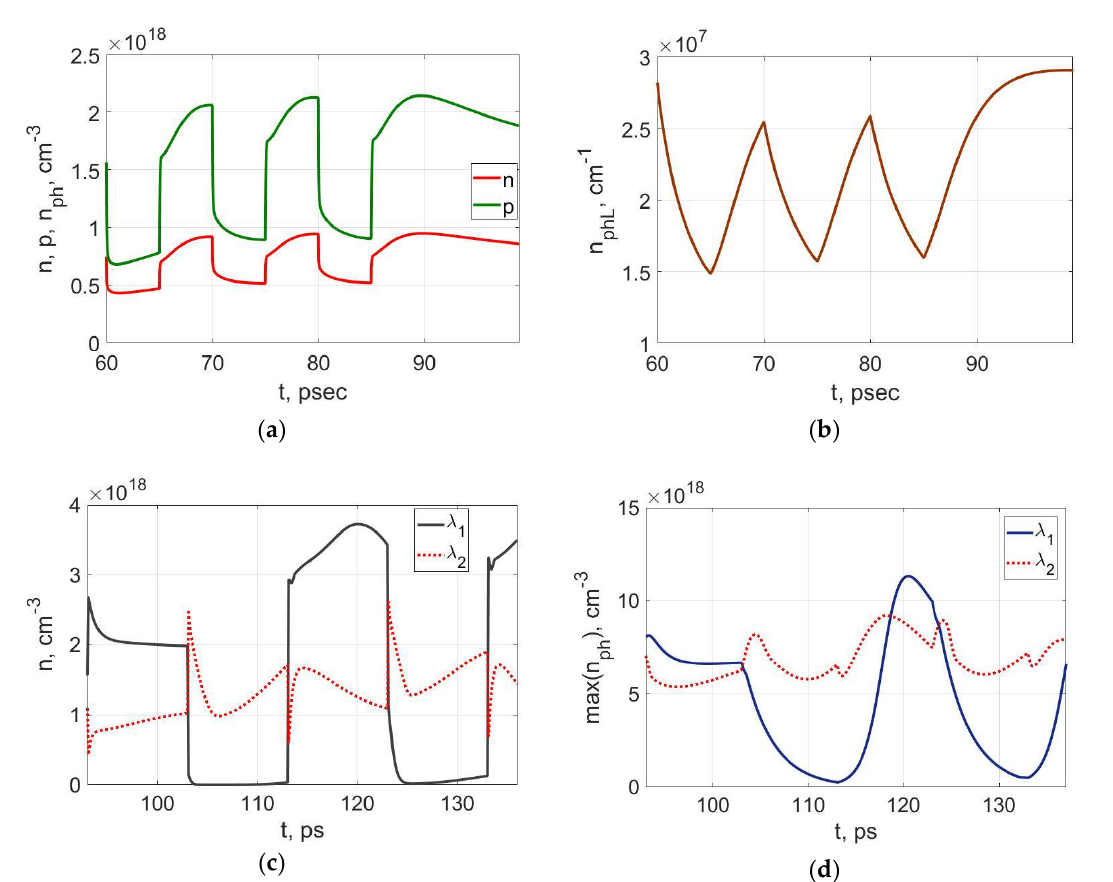
Figure 3. The results of time-domain drift-diffusion simulation of the lasers with functionally integrated amplitude ( a , b ) and frequency ( c , d ) modulators: carrier densities in the central cross-section of the active region ( a ) and linear density of photons ( b ); electron ( c ) and peak photon ( d ) densities in the regions, which generate optical radiation with λ 1 and λ 2 wavelengths (electron density corresponds to the central cross-section of the active